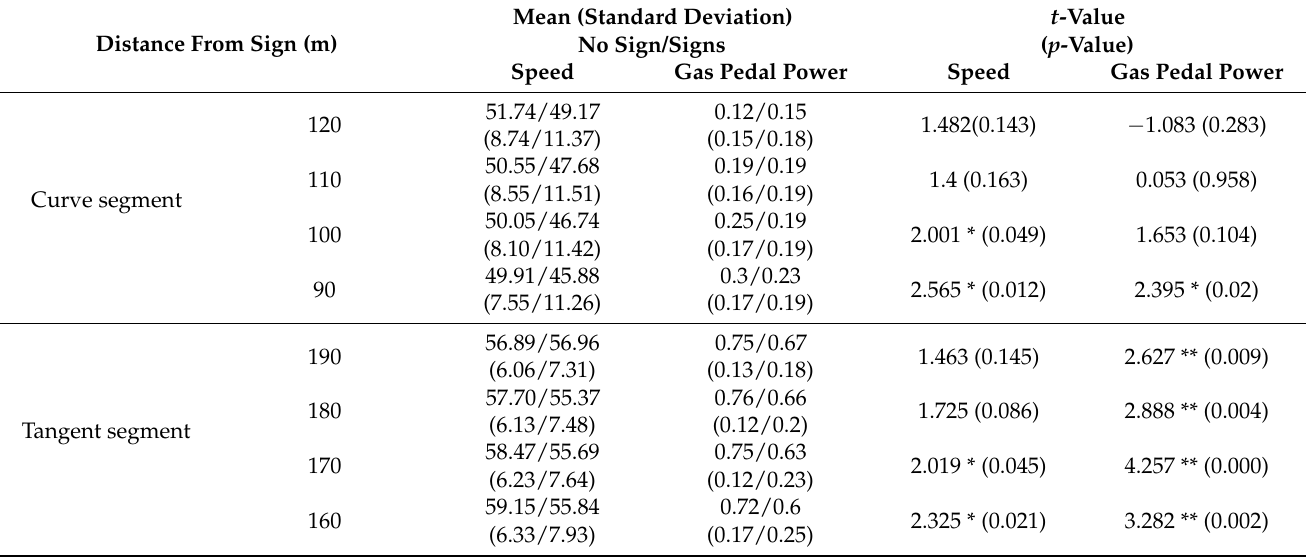
Table 2. Speed and gas pedal power comparison between no-sign conditions and signs in t -test for two